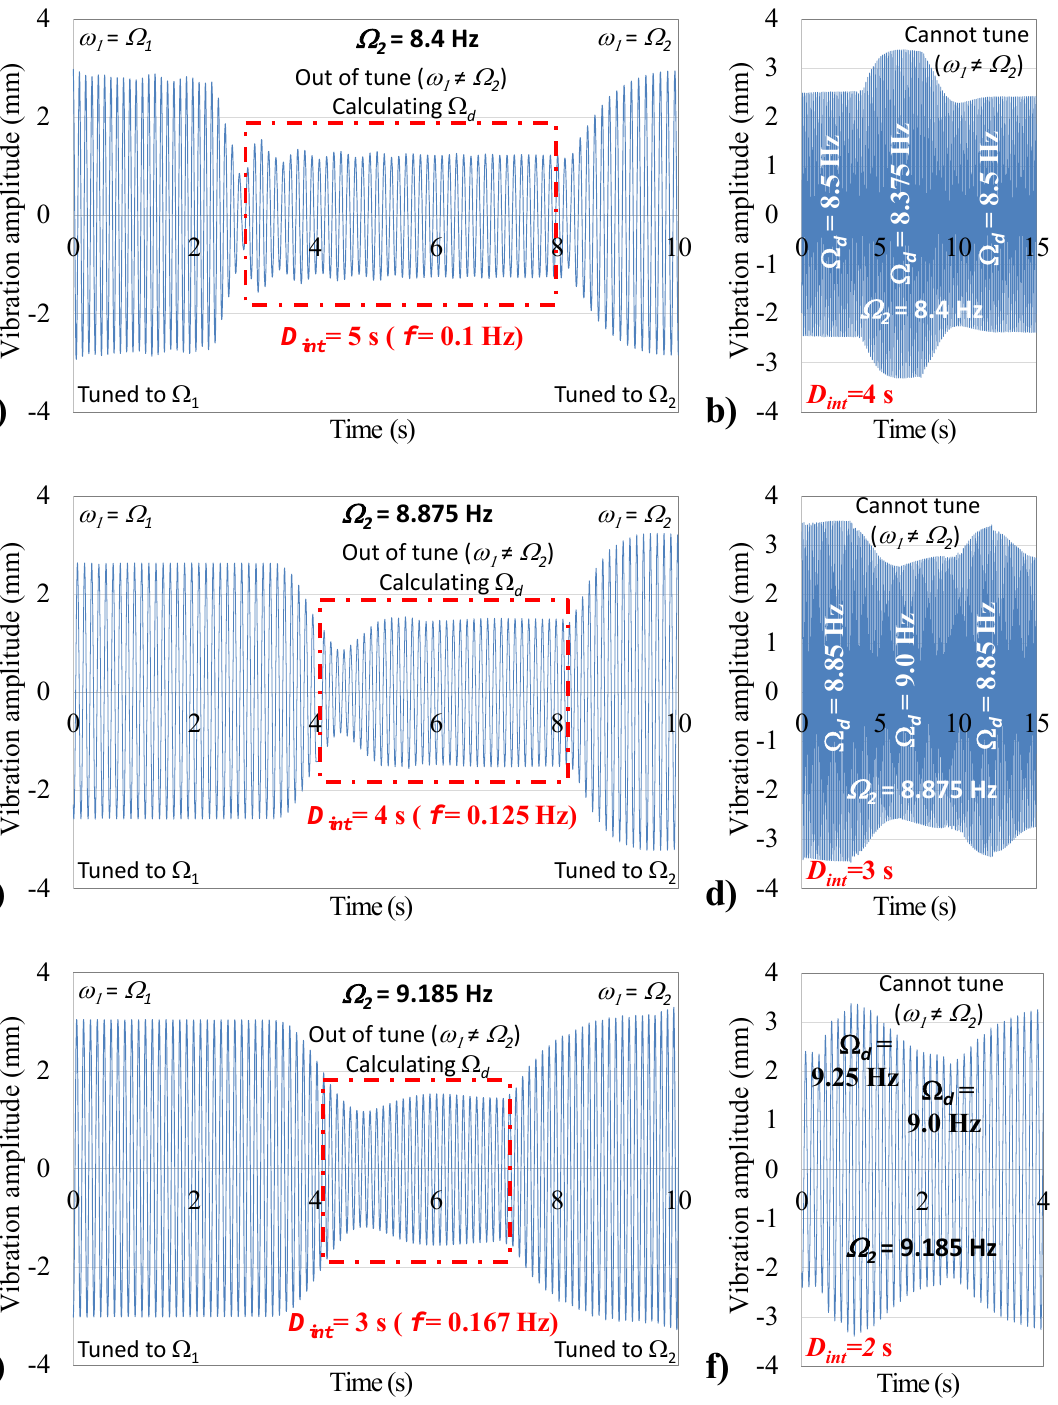
Figure 8. Effect of detection interval D int on system response at x = L , presented at ( a ) Ω 2 = 8.4 Hz and D int = 5 s, ( b ) Ω 2 = 8.4 Hz and D int = 4 s, ( c ) Ω 2 = 8.875 Hz and D int = 4 s, ( d ) Ω 2 = 8.875 Hz and D int = 3 s, ( e ) Ω 2 = 9.185 Hz and D int = 3 s, and ( f ) Ω 2 = 9.185 Hz and D int = 2